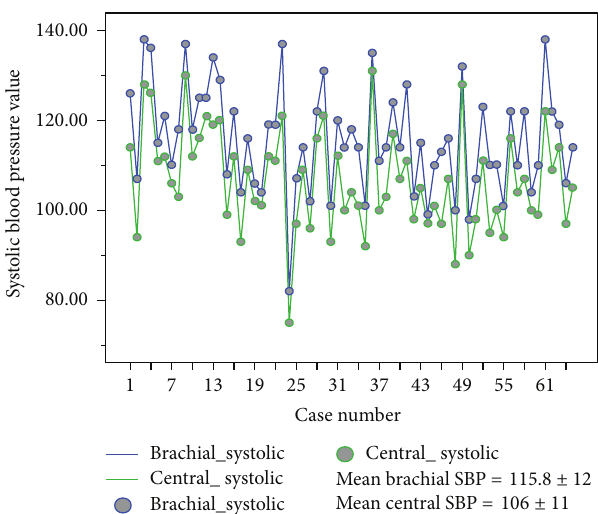
Figure 3: Brachial and central systolic blood pressure measure- ments.